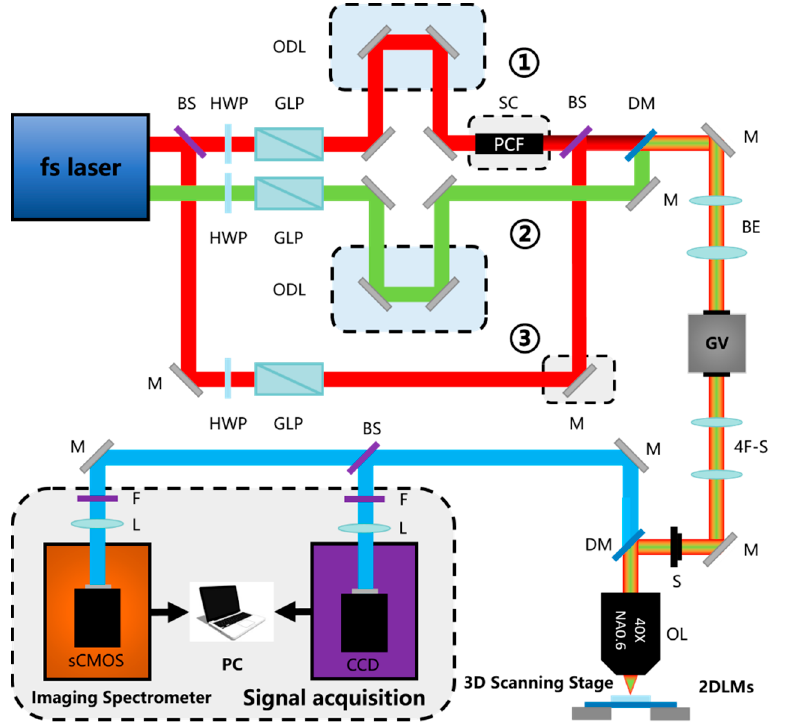
Figure 15. System instrument of our group. HWP: half-wave plate; GLP: Glan-Laser polarizer; ODL: optical delay line; PCF: photonic crystal fiber; SC: supercontinuum; DM: dichroic mirror; BS: beam splitter; GV: galvanometer; 4F-S: 4F system; sCMOS: scientific complementary Metal-Oxide-Semiconductor detector; BE: beam expander; OL: objective lens; F: filter.